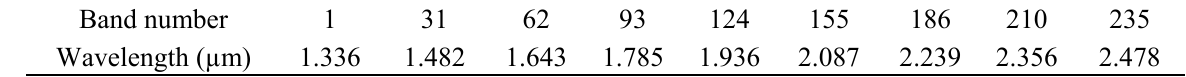
Table 3. HySpex SWIR-320m band subset used in